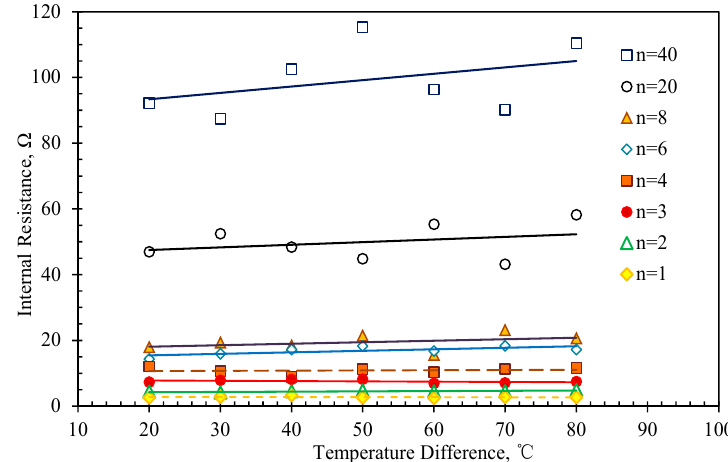
Figure 4. Relationship between internal resistance and ∆ T for different quantity of modules ( n in the diagram is the number of thermoelectric modules in series).